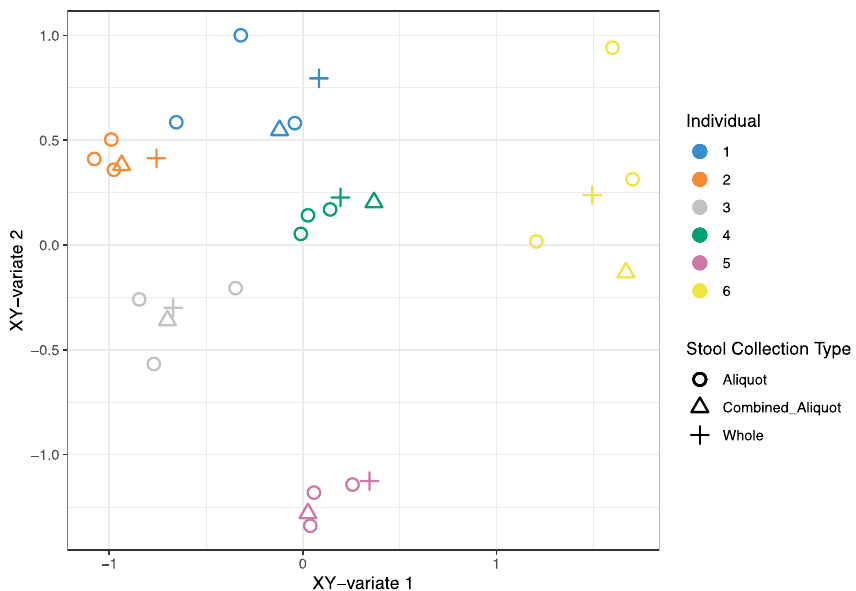
Figure 3. Variability of bacterial community and SCFA composition due to stool homogenization methods. Datasets where combined using rCCA in the R package MixOmics 61 , correlation coefficients were plotted in the shared X–Y space. Bacterial ASV counts were CLR transformed, and SCFA concentration were log10 transformed.